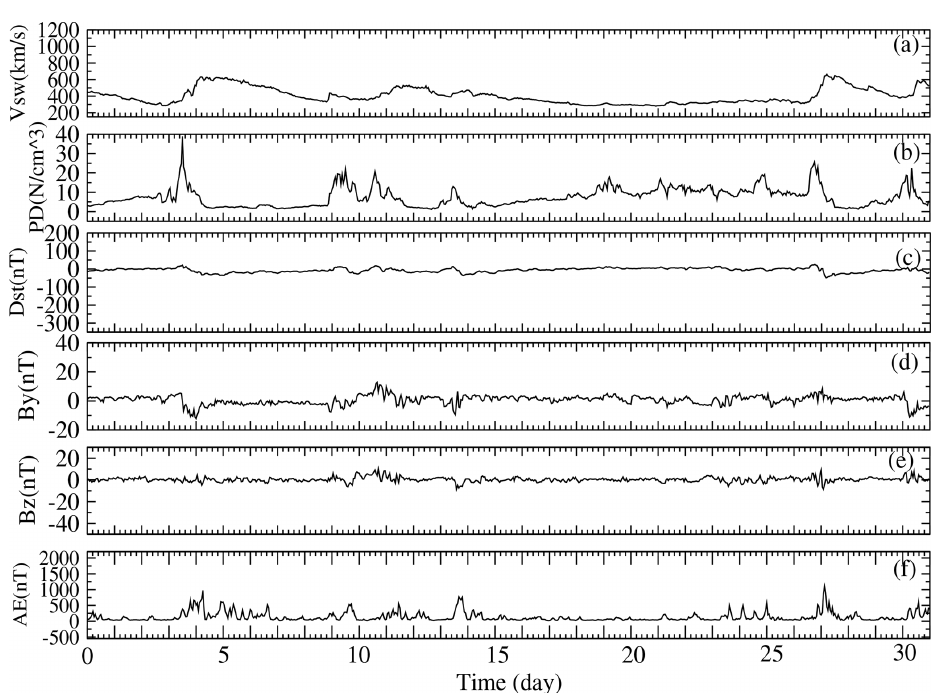
Figure 2. The 1h averaged variations in V sw , PD, Dst, IMF B y and B z and AE for the geomagnetically quiet solar minimum interval